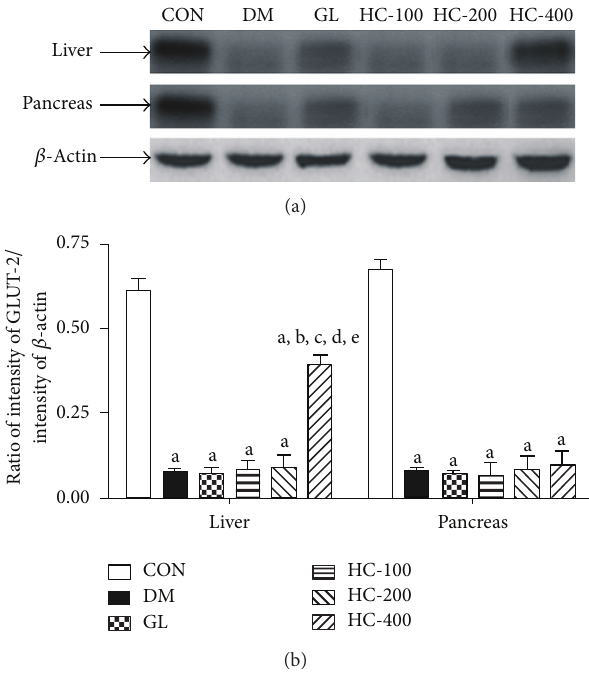
Figure 7: Effect of HC (100, 200 and 400 mg/kg) on STZ-induced changes in the levels of expression of GLUT-2 in liver and pancreas. The blots (a) are representative of GLUT-2 in liver and pancreas. The results in the histogram (b) are expressed as ratio of relative intensity of levels of protein expression of GLUT-2 to 𝛽 -Actin. All values are mean ± SEM of three separate sets of independent experiments. a 𝑃 < 0.05 compared to normal control; b 𝑃 < 0.05 compared to diabetic control; c 𝑃 < 0.05 compared to glibenclamide; d 𝑃 < 0.05 compared to HC 100; e 𝑃 < 0.05 compared to HC 200 (one-way ANOVA followed by Tukey’s multiple comparison